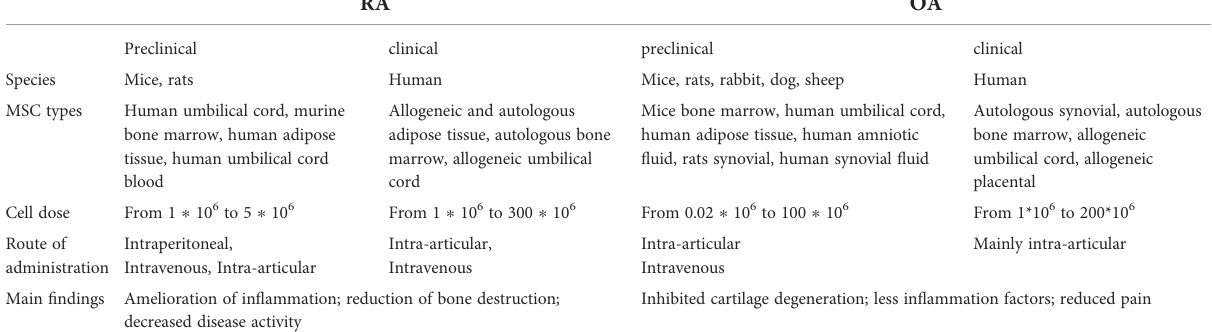
TABLE 5 Comparison of RA and OA in MSCs